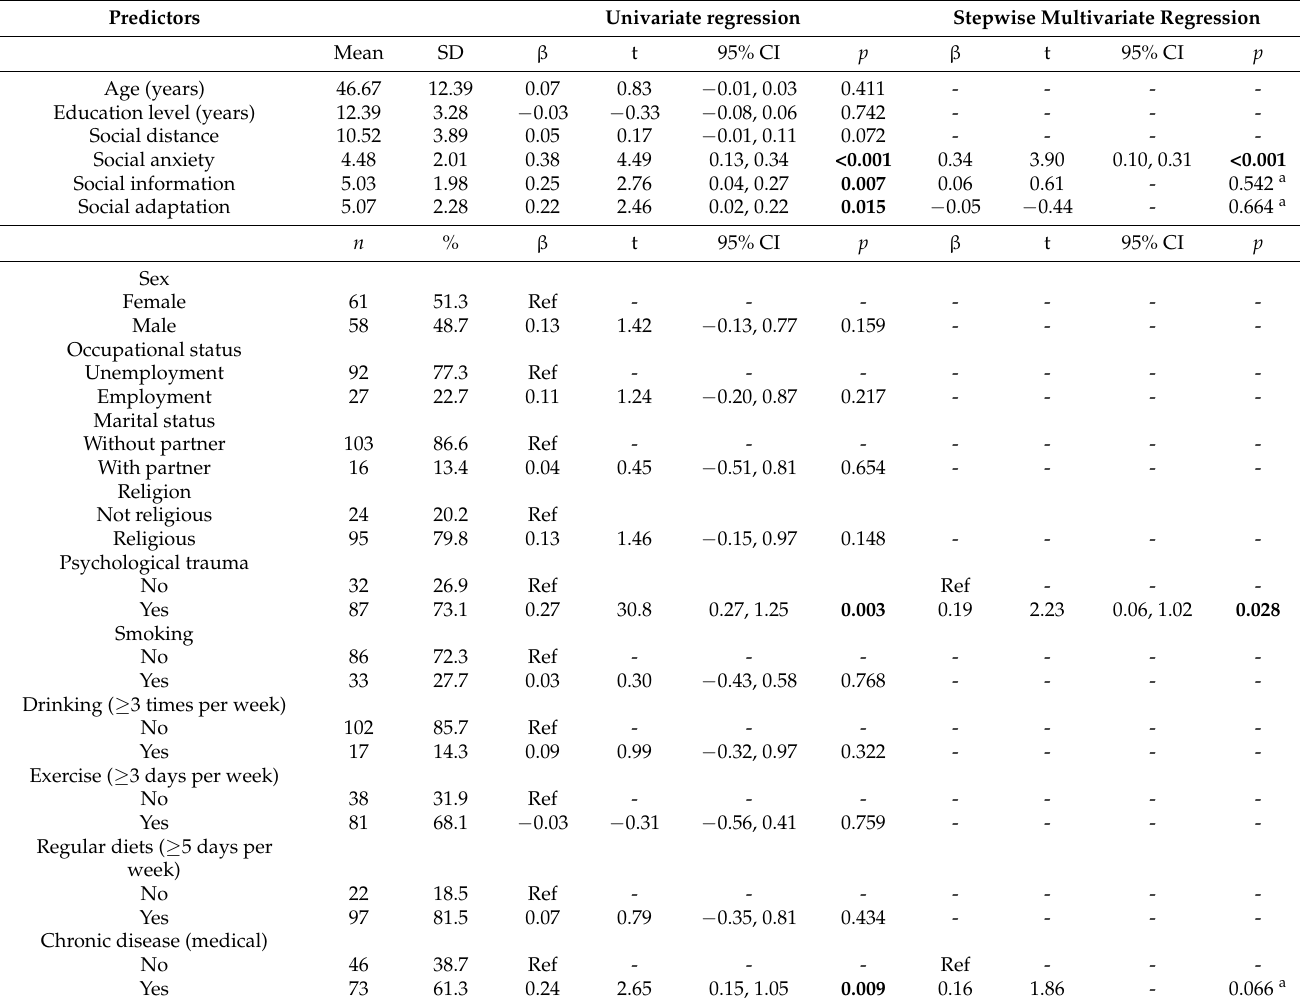
Table 3. Predictors for level of physical pain examined by univariate linear regression and stepwise multivariate linear regression (N =